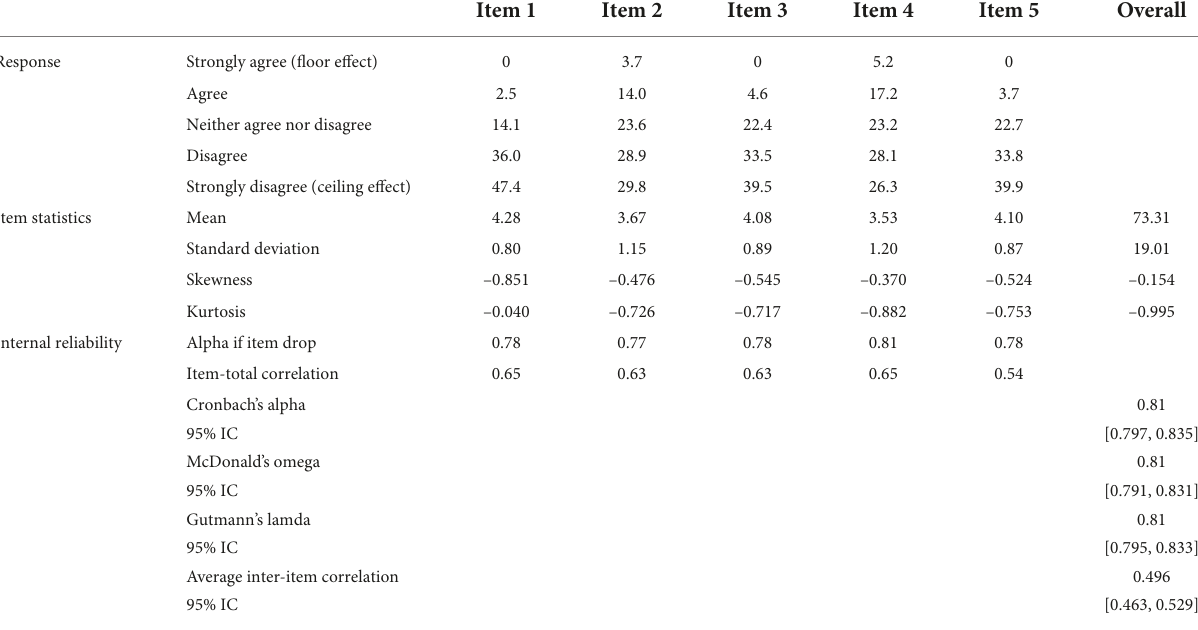
TABLE 3 DRS item statistics and reliability.